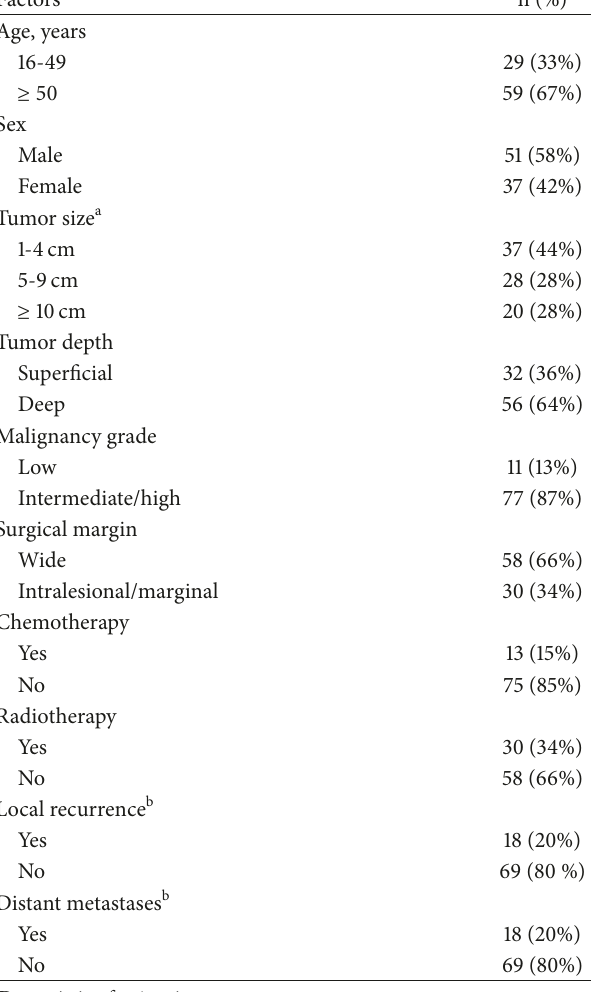
Table 2: Histological types of soft tissue sarcomas.